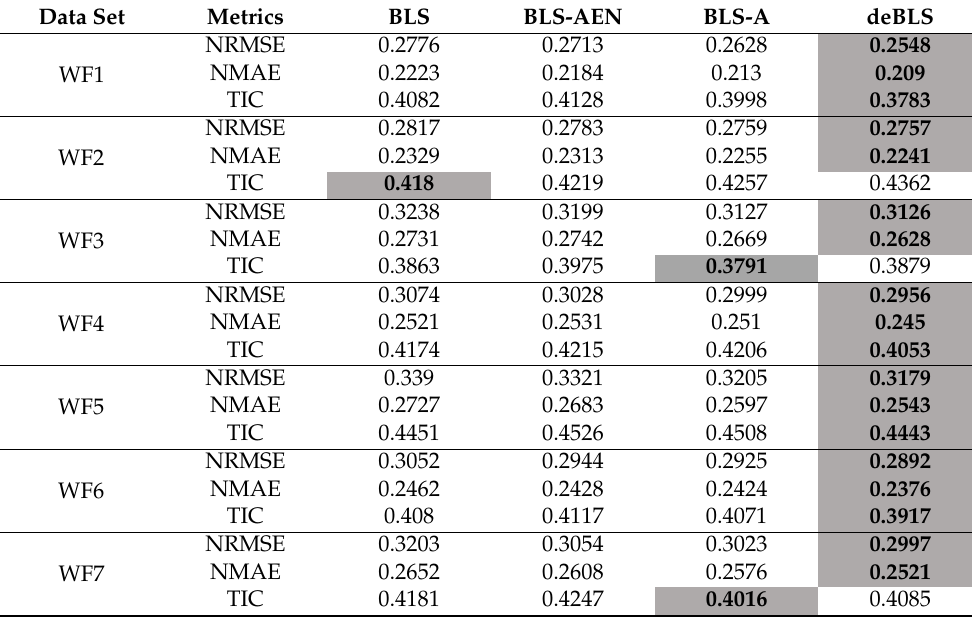
Table 3. The assessment results of BLS, BLS-AEN, BLS-A, and